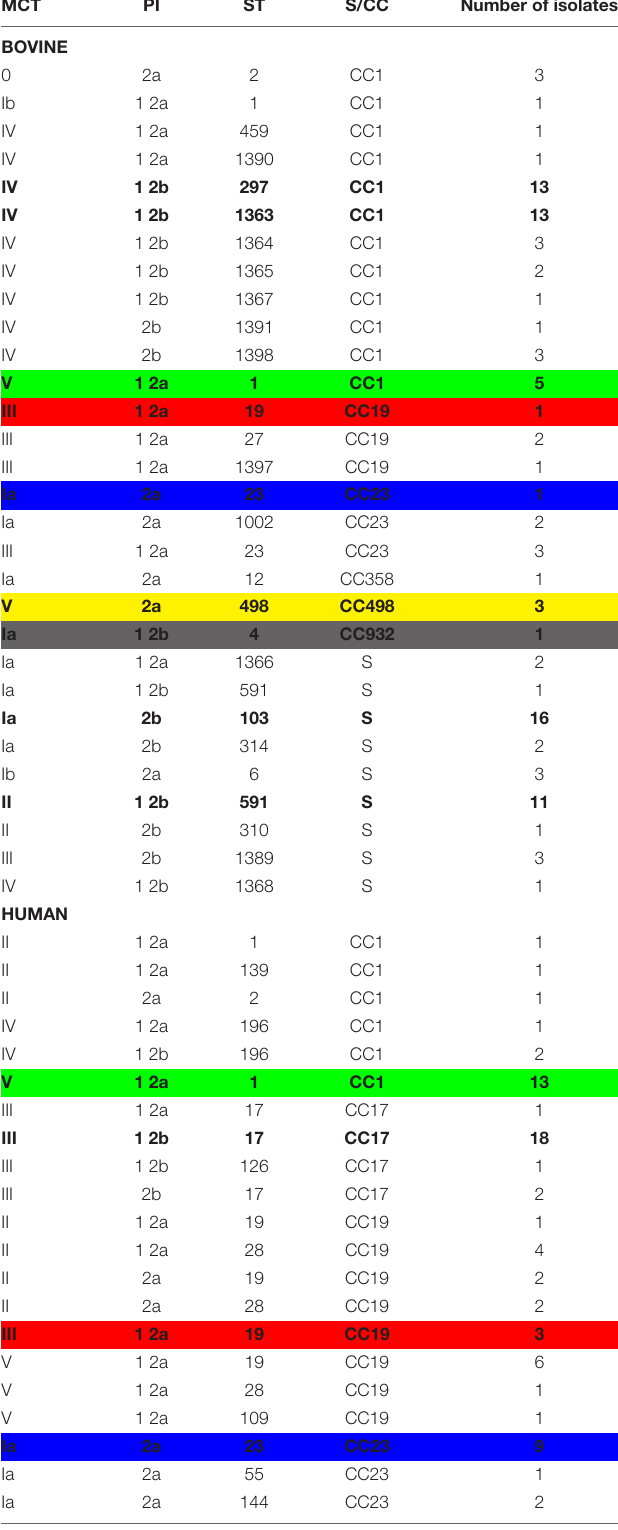
TABLE 2 | Results of the molecular capsular typing, pilus island typing, and multi-locus sequence typing of 201 Streptococcus agalactiae isolates. MCT PI ST S/CC Number of isolates